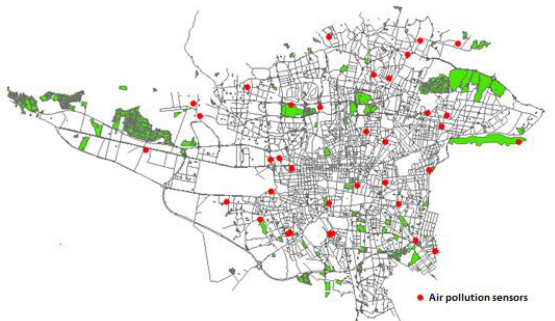
Figure 2. The map of Tehran's roads, parks and air pollution monitoring stations